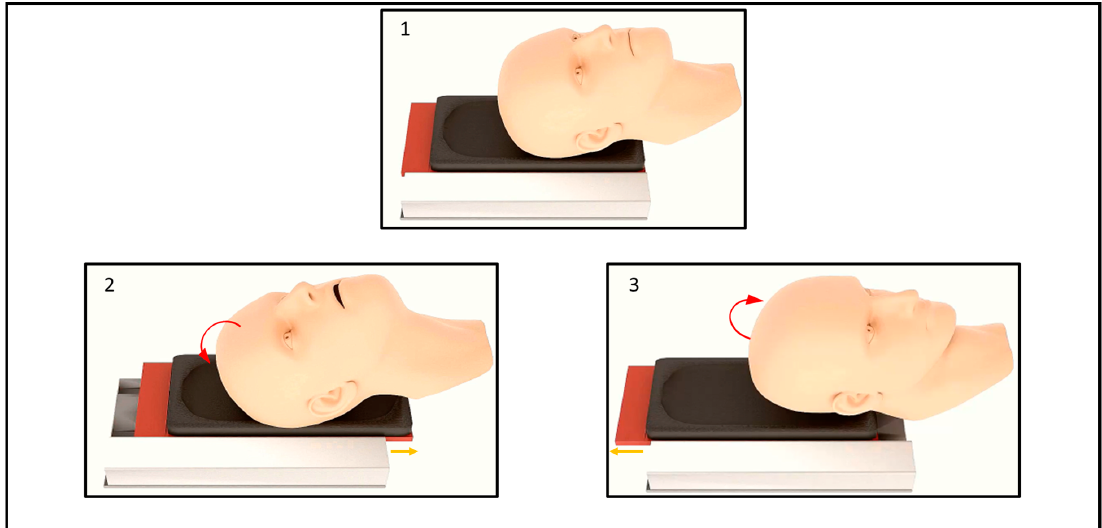
Figure 1. Rendering of the Spinetrack device. The figure shows the movement of the cervical spine performed by the patient on the Spinetrack device and the direction of movement of the mobile platform. ( 1 ) Cervical rest on the Spinetrack device in neutral position. ( 2 ) Cervical movement to extension, the mobile platform moves to caudal ( 3 ) Cervical movement to flexion, the mobile platform moves to cranial.